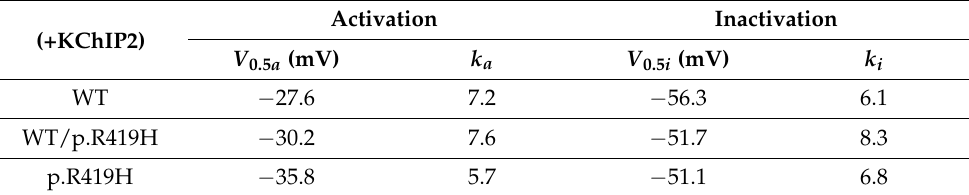
Table 2. Comparison of the K V 4.3 voltage-dependent gating parameters of the wild type (WT) and the p.R419H variant. Steady-state activation and inactivation curves were generated from the averages of 9–12 cells expressing the indicated K V 4.3 constructs. Data were subject to fitting with the Boltzmann equation as described in the Materials and Methods section and depicted in Figure 4. V 0 . 5 a : half-activation voltage. k a : activation slope factor. V 0 . 5i : half-inactivation voltage. k i : inactivation slope